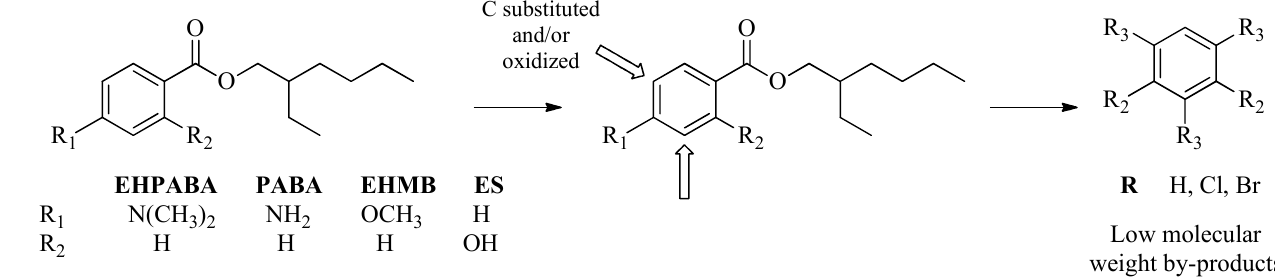
Scheme 7. Chemical filters derived from p -aminobenzoic acid and possible reactive